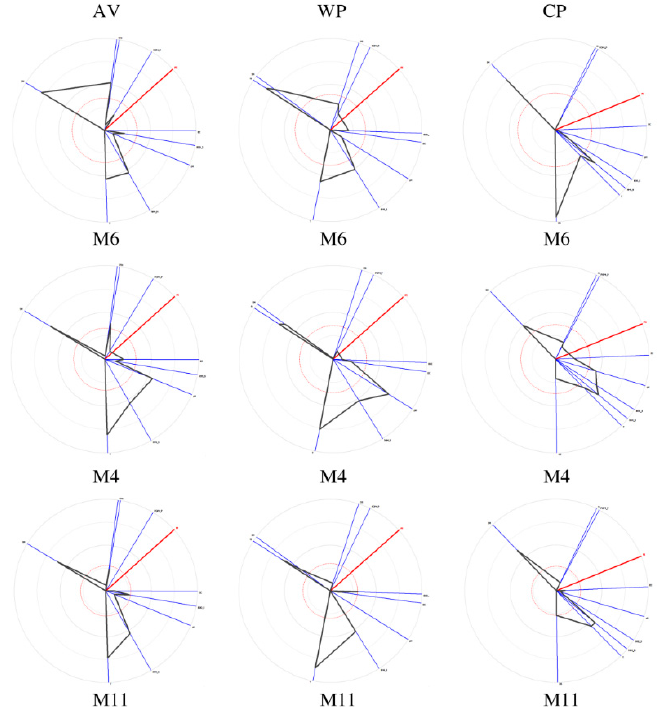
Figure 6. GAIA web of the locations M6, M4, and M11 observed in AV, WP, and CP periods, re- spectively.